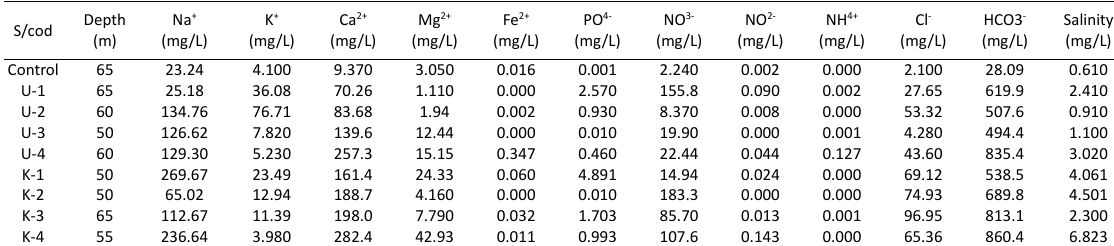
Table 5: Chemical parameters in wet season (mg/L)